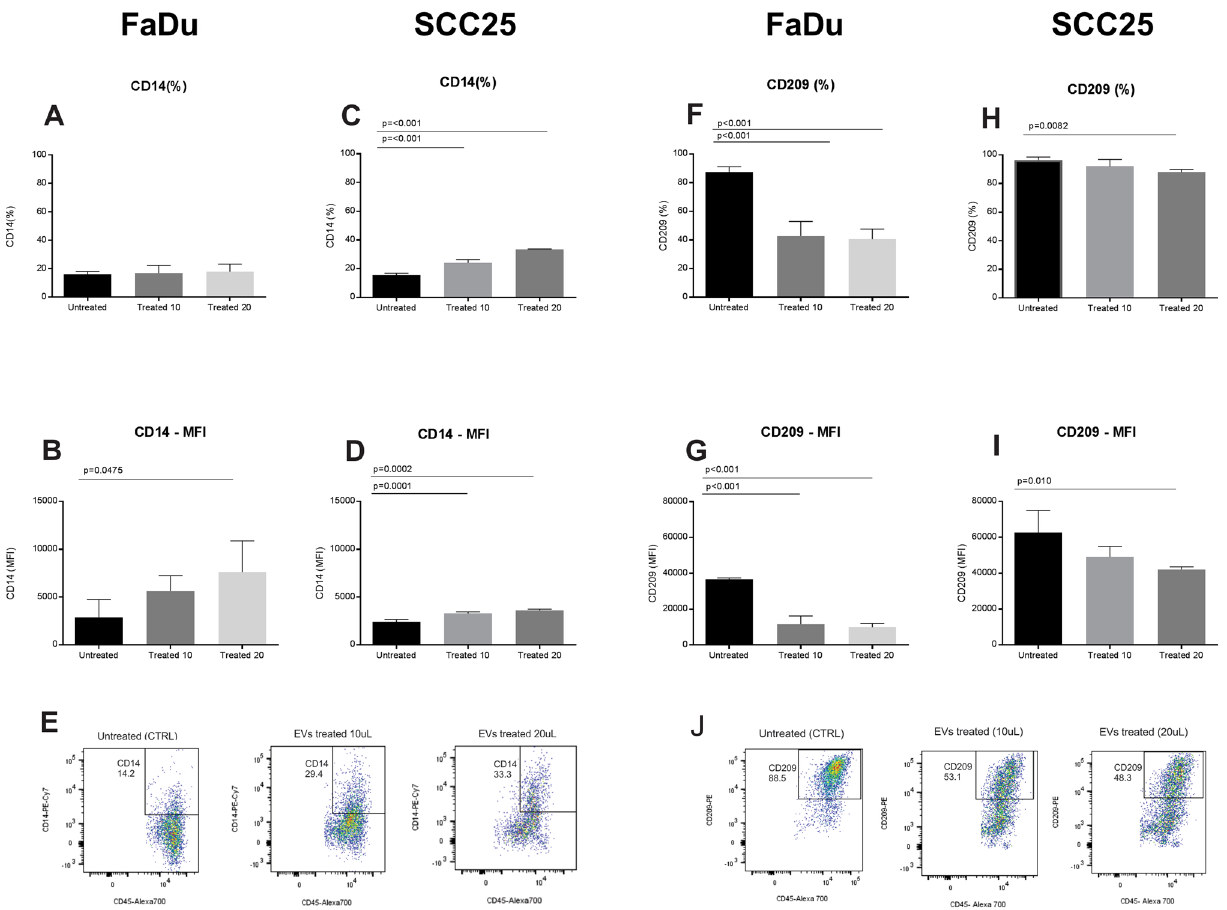
Figure 7. Expression of CD14 and CD209 during dendritic cell differentiation in the presence and absence of EV. CD14 expression following treatment with FaDu cell line EVs: ( A ) There were no significant differences in the percentage of iDCs expressing CD14 between control (16.2% ± 1.8%) and EV treated cells (17.1 ± 5.3% and 17.9 ± 5.5%); ( B ) there were significant differences in the mean intensity of fluorescence (MFI) of CD14 in iDCs between the control (2884 ± 1857) and EV treated samples (5636 ± 1613 and 7605 ± 3265) depending of EV concentration. CD14 expression following treatment with SCC25 cell line EVs: ( C ) There were significant differences in the percentage of iDCs expressing CD14 between the control (15.5 ± 1.3%) and EV treated cells (24.0 ± 2.3% and 33.5 ± 0.3%) depending on EV concentration; ( D ) there were significant differences in CD14 MFI between control (2402 ± 253) and EV treated cells (3275 ± 170 and 3623 + 111) depending on EV concentration; ( E ) Representative dot plots displaying iDCs expressing CD14 on day 6 of culture without treatment (CTRL) and EV-treated cells. CD209 expression following treatment with FaDu cell line EVs: ( F ) There were significant differences in the percentage of iDCs expressing CD209 between control (87.4 ± 3.8%) and EV treated cells (42.8 ± 10.2% and 40.5 ± 7.1%); ( G ) there were differences between untreated iDCs MFI (36,670 ± 802) and treated iDCs (11,543 + 4719 and 9900 ± 2034). CD209 expression following treatment with SCC25 cell line EVs: ( H ) there were significant differences in iDCs expressing CD209, between the control (96.5 ± 2.1%) and treated cells (92 ± 4.8% and 87.9 ± 1.9%), depending on EV concentration; ( I ) there were differences between untreated iDCs MFI (62,514 + 12,407) and treated cells (49,110 ± 5632 and 42,011 ± 1568) (n = 4); ( J ) Representative dot plot graphs displaying iDCs expressing CD209 on day 6 of culture without treatment (CTRL) and EV-treated cells with different concentrations of EVs. Representative results of n = 4 samples per lineage type. The statistical analysis was performed using one way ANOVA with Dunnett